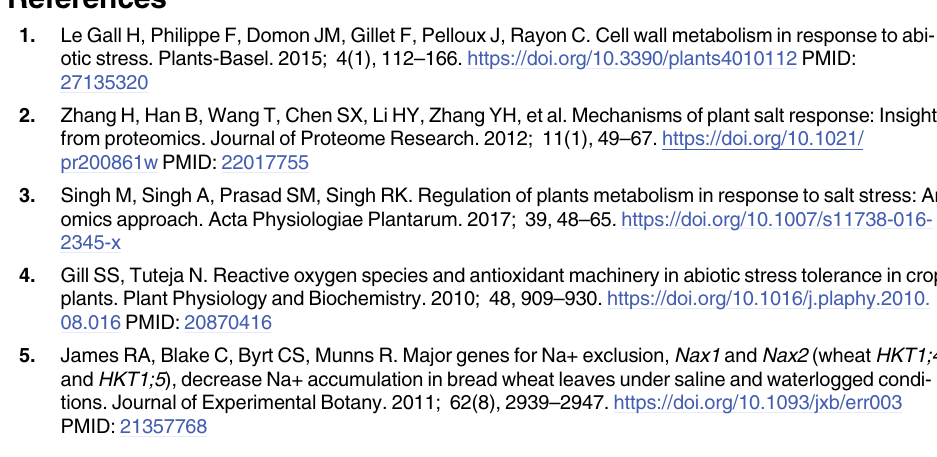
S1 Table. Primer sequences of differentially expressed genes for q-PCR validation. S2 Table. Statistics of RNA-Seq